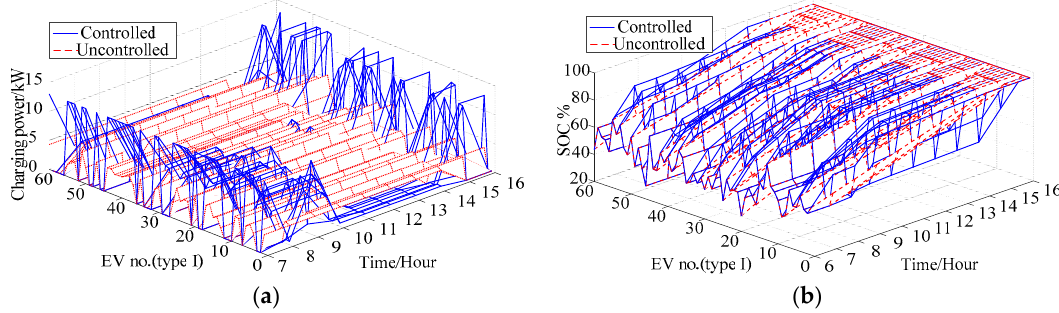
Figure 8. Charging rate and state of charge (SOC) profiles of EV type I at fast charging facilities with and without control: ( a ) EV charging curves (Tesla Model X); ( b ) SOC curves during the parking period.